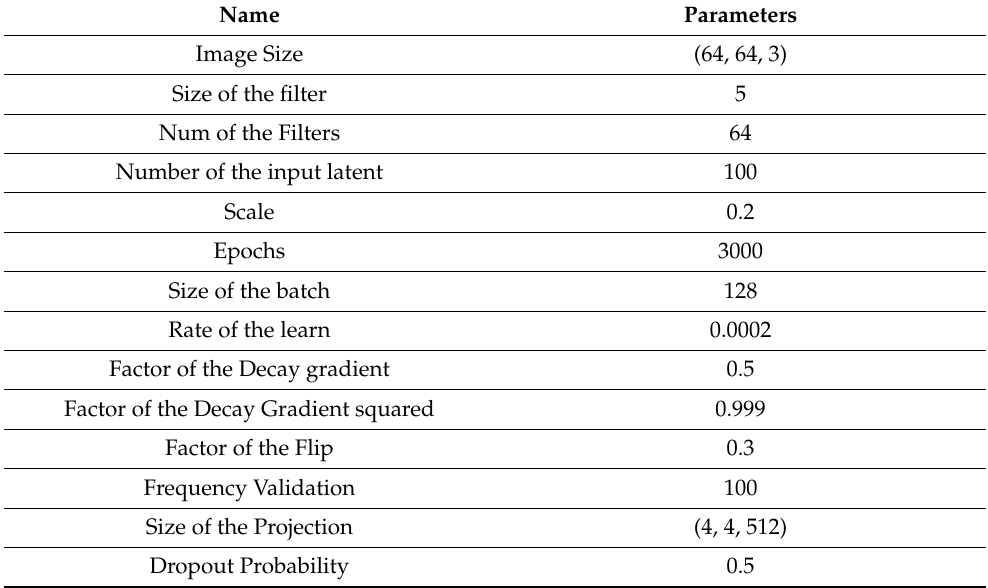
Table 1. Parameters of GAN model.